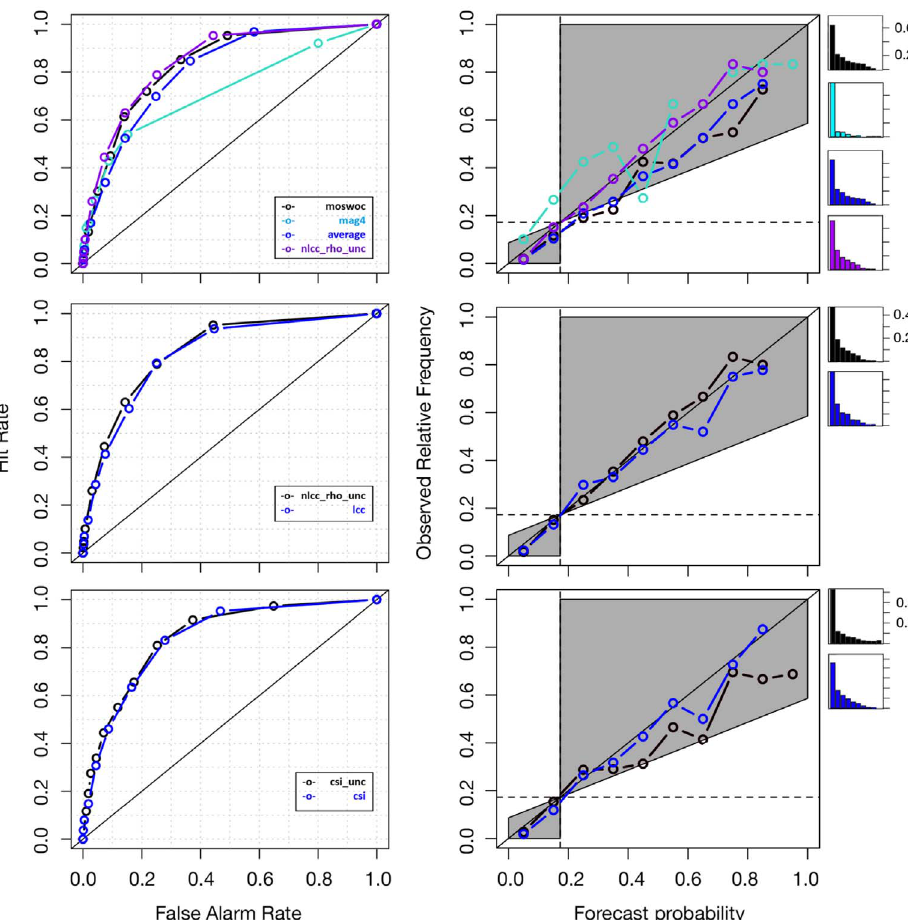
Fig. 6. ROC curves ( left column) and reliability diagrams ( right column) for M-class fl are forecasts, comparing the top ranking individual method types and fi nal ensemble performer ( upper row), and for constrained and unconstrained ensembles based on probabilistic ( middle row) and categorical ( lower row) metrics. Note that the center diagonal line in the ROC curves represents no skill, while for the reliability diagrams it indicates perfect reliability. The shaded areas in the reliability diagrams indicate regions that contribute positively to the Brier skill score (not shown/used